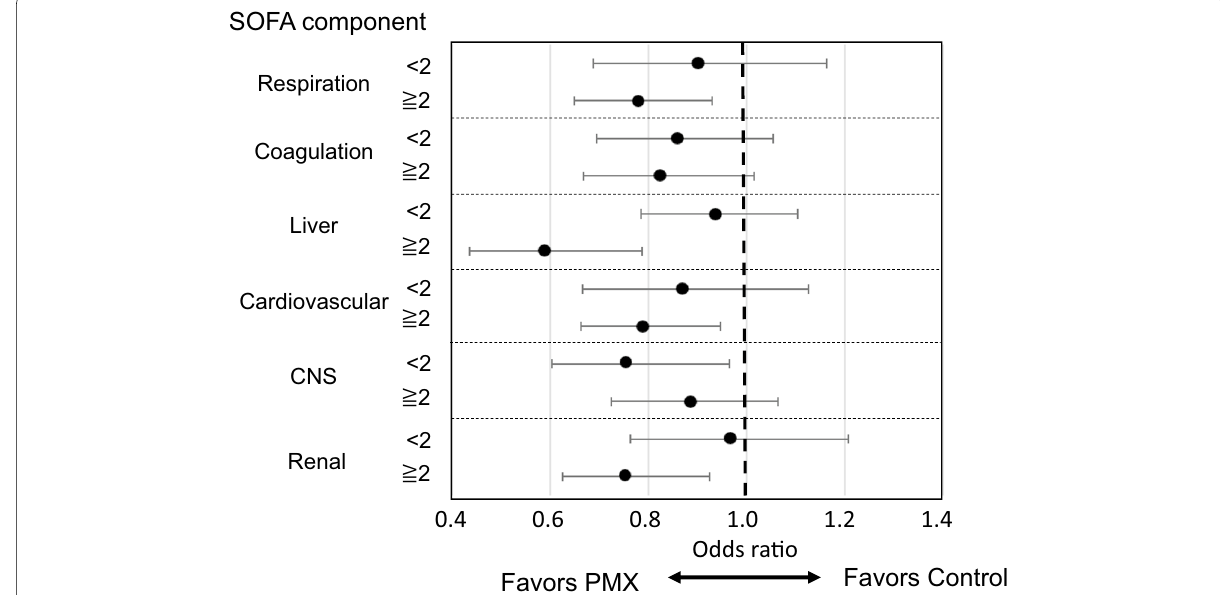
Fig. 3 Odds ratio of 28-day mortality across subsets defined according to individual SOFA score components of each